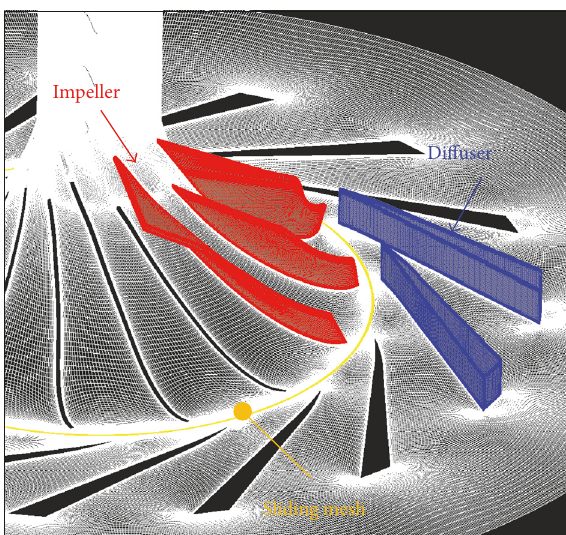
Figure 3: Overview of computational grid.